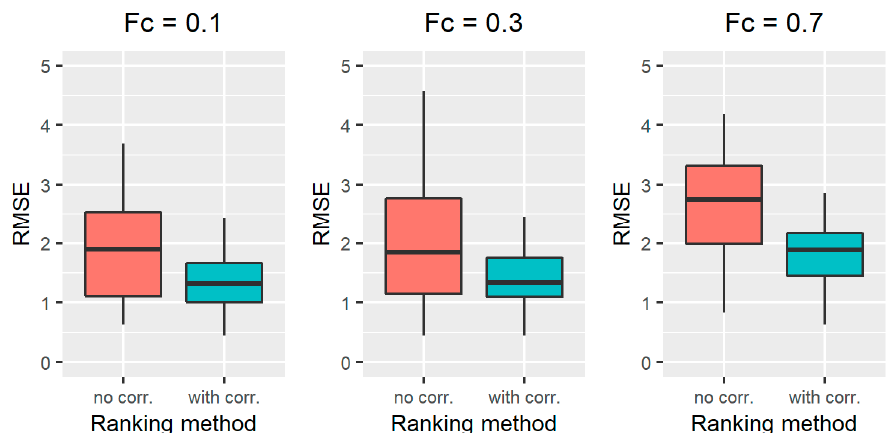
Figure 4. RMSE results obtained for the standard RFE-Borda count method (red boxplot, “no corr.” label) and the proposed algorithm (green boxplot, “with corr.” label) for scenarios 7–9, characterized by a number of training samples equal to 250 ( left ), 500 ( middle ), and 1500 ( right ).